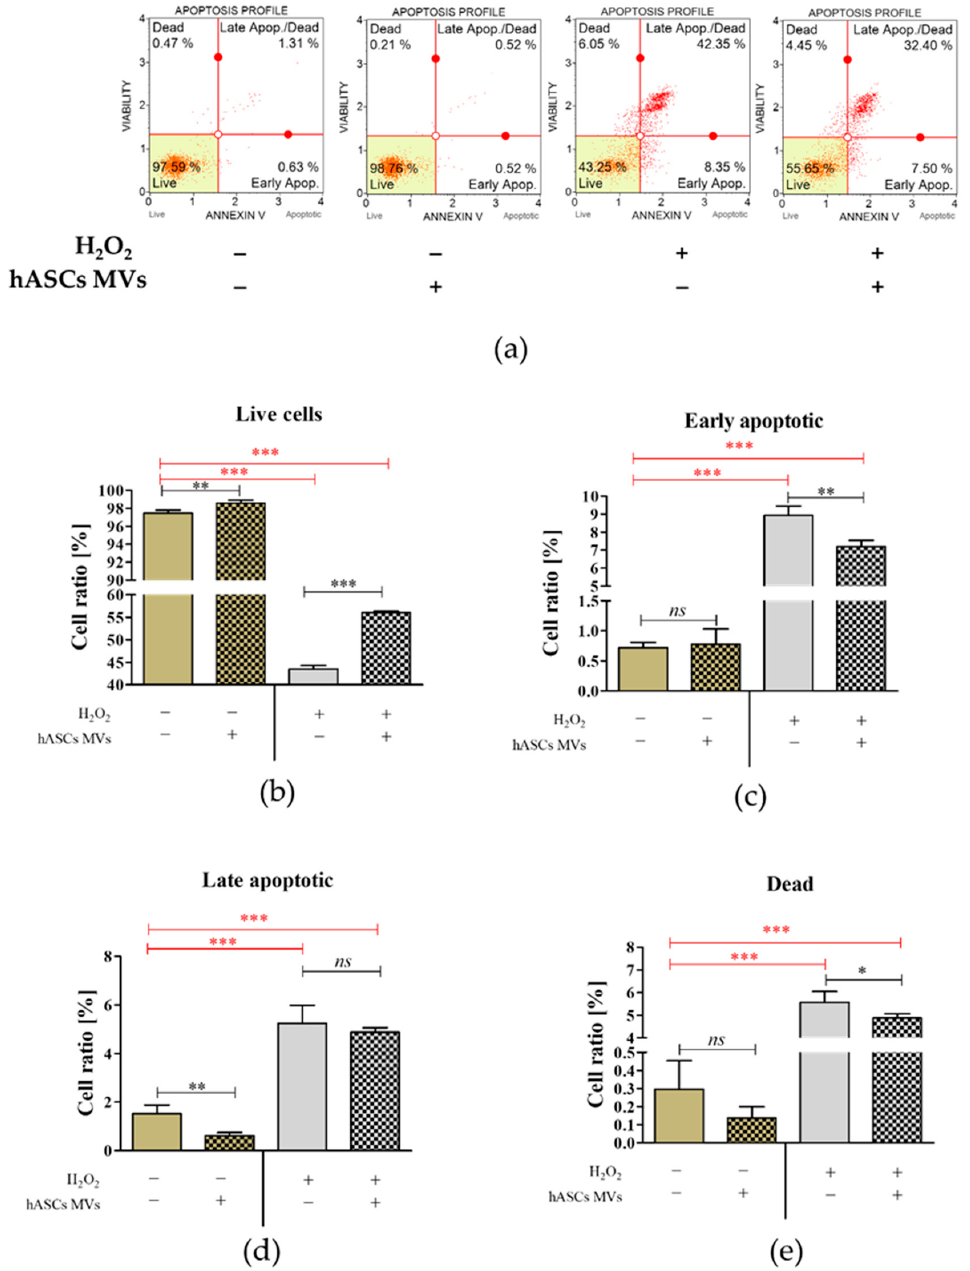
Figure 3. The influence of MVs on CaMLCs viability under both normal and oxidative stress conditions induced by H 2 O 2 .The analysis of cells viability was performed using Muse ® Annexin V and Dead Cell Assay Kit. The representative dot plots show the distribution of cells into four populations ( a ). The populations were determined based on the fluorescence of Annexin V and 7-AAD dye.—live (lower left quadrant; Annexin V − / 7-AAD − ), early apoptotic (lower right quadrant; Annexin V +/ 7-AAD − ), late apoptotic (upper right quadrant; Annexin V +/ 7-AAD + ), and dead cells (upper left quadrant; Annexin V +/ 7-AAD + ). Comparative statistical analysis was performed in order to determine the influence of experimental condition on cells’ viability ( b ) and apoptosis profile ( c , d ). The presence of dead cells (nuclear debris) was also determined ( e ). An asterisk highlights the statistically significant di ff erence (* p ≤ 0.05; ** p ≤ 0.01 and *** p ≤ 0.001) and di ff erences between healthy cultures and cultures with induced oxidative stress are marked with red font. The results are expressed as mean ±